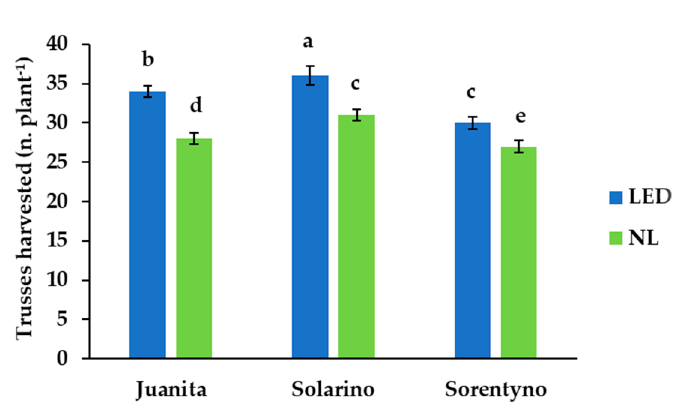
Figure 2. Number of the trusses harvested at the end of the growing cycle of three tomato cultivars grown with LEDs, used as supplemental light, and with natural light. Vertical bars indicate ± standard error (SE). The same lowercase letters indicate that the mean values are not significantly different ( p = 0.05).